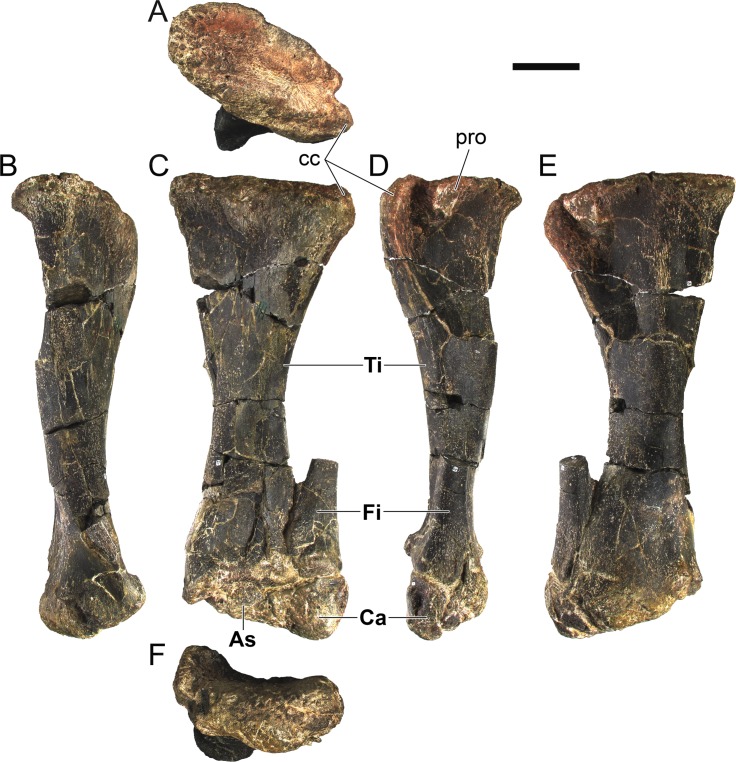
Left tibia, tarsus and distal fibula of Miragaia longicollum MG 4863.A, dorsal, B, medial, C, anterior, D, lateral, E, posterior, and F, ventral view. As, astragalus, Ca, calcaneum, cc, cnemial crest, Fi, distal fibula, pro, process. Scale bar equal to 10 cm.